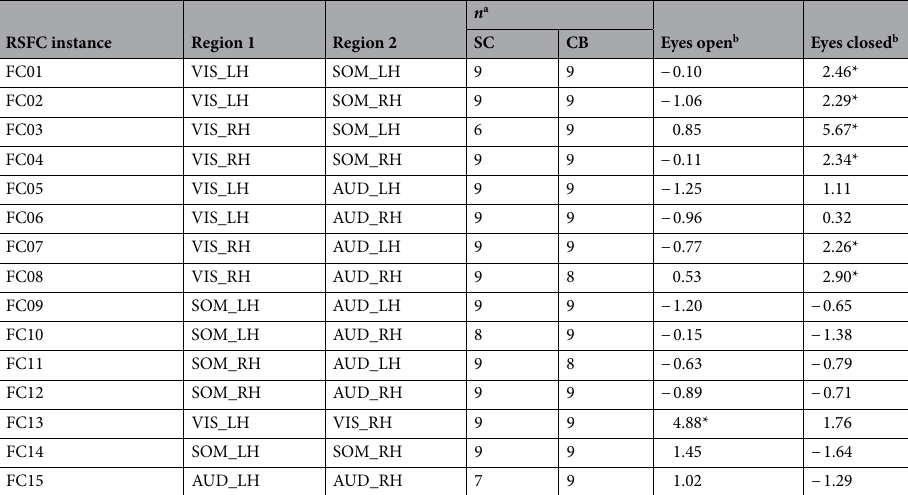
Table 4. Summary of post-hoc, independent-sample t -tests in Study 2. RSFC = resting-state functional connectivity; CB = congenitally blind; SC = sighted controls; FC = functional connectivity; VIS = visual region; LH = left hemisphere; SOM = somatosensory region; RH = right hemisphere; AUD = auditory region. a Sample size after outlier removal. b Positive t values indicate that the mean was higher in the normally sighted group than in the congenitally blind group, whereas negative t values indicate that the mean was lower in the normally sighted group than in the congenitally blind group. * p <